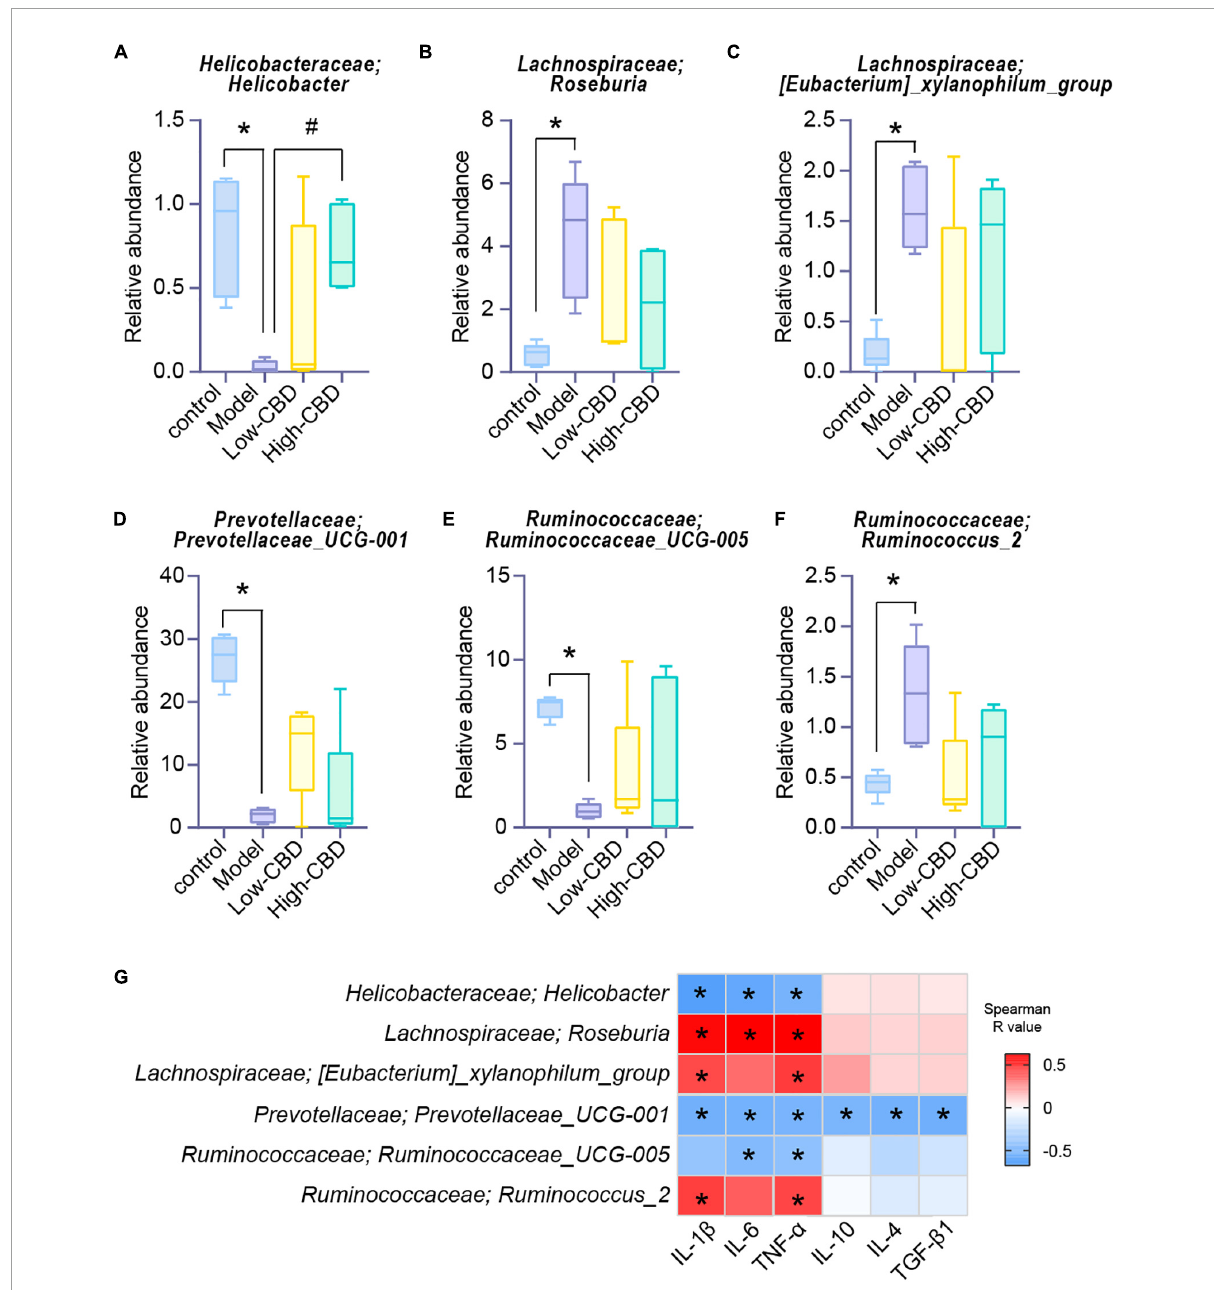
FIGURE6 Effects of cannabidiol (CBD) on the changes of the abundance of gut microbiota in rats with Epilepsy. (A-F) At the genus level, the abundance of Helicobacter , Roseburia , [Eubacterium]_xylanophilum_group , Prevotellaceae_UCG-001 , Ruminococcaceae_UCG-005 , and Ruminococcus_2 . *Represents significant comparison with the control group, #represents significant comparison with the Model group, P < 0.05. (G) Correlation analysis of gut bacteria and cytokines. Blue represents negative correlation, and red represents positive correlation; The larger the absolute value of R, the stronger the correlation; *indicates significant